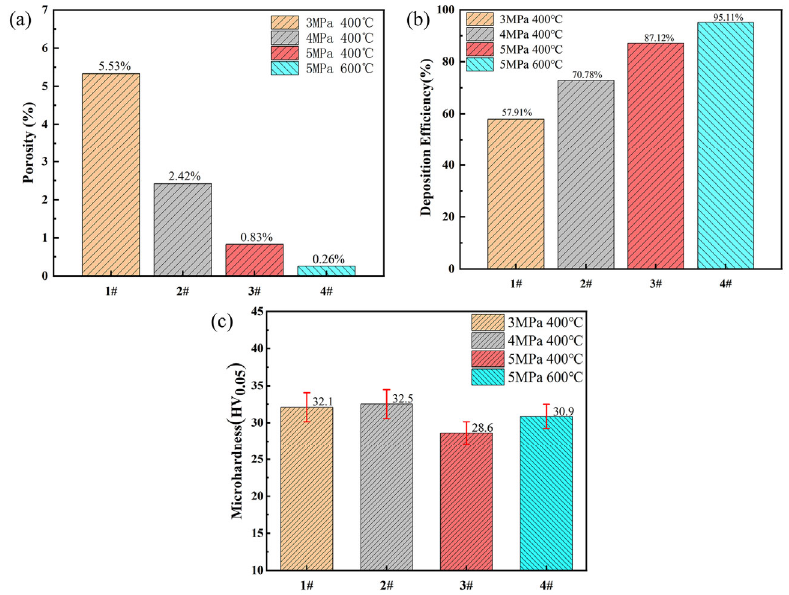
Figure 4. Key metrics of cold-sprayed Al coatings: ( a ) porosity, ( b ) deposition efficiency, and ( c ) microhardness.